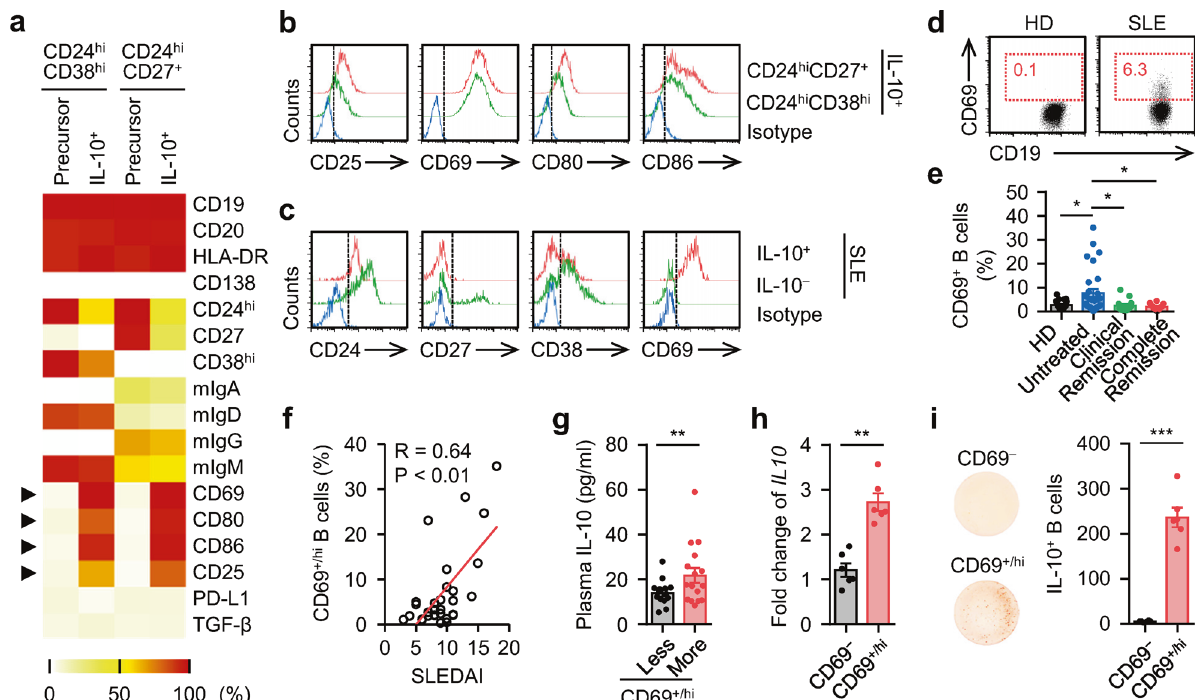
Fig. 2 Phenotypic characteristics of IL-10-secreting B reg cells in SLE a , b FACS analysis of the phenotypic characteristics of the untreated CD24 hi CD38 hi and CD24 hi CD27 + B cells (precursor), as well as IL-10 + cells derived from CD24 hi CD38 hi and CD24 hi CD27 + B cells by CPG-DNA induction ( a ). Representative histogram of CD25, CD69, CD80, and CD86 expression were shown in b ( n = 5). c Expression of CD24, CD27, CD38, and CD69 in IL-10 + B cells puri fi ed from untreated SLE patients was detected by FACS ( n = 6). d , e FACS analysis of CD69 + /hi B cells from healthy donors and untreated SLE patients. Representative FACS plots were shown in d . The portions of CD69 + /hi B cells relative to total B cells from 21 healthy donors, 30 untreated SLE patents, 14 clinical remission SLE patients, and 12 complete remission SLE patients were shown in e . f , g Associations of circulating CD69 + /hi B cells with disease progression ( f ) and plasma level of IL-10 from untreated SLE patients ( g ) ( n = 30). h , i Expression of IL-10 by CD69 − and CD69 + /hi B cells isolated from untreated SLE patients were detected by PCR ( h ) and ELISpot ( i ), respectively (each n = 6). Data were acquired from more than four independent experiments and shown as means ± SEM. Pearson ’ s correlation analysis for f . Signi fi cance was determined with one-way ANOVA test ( e ), Student ’ s t test ( g – i ). * p < 0.05, ** p < 0.01, *** p <